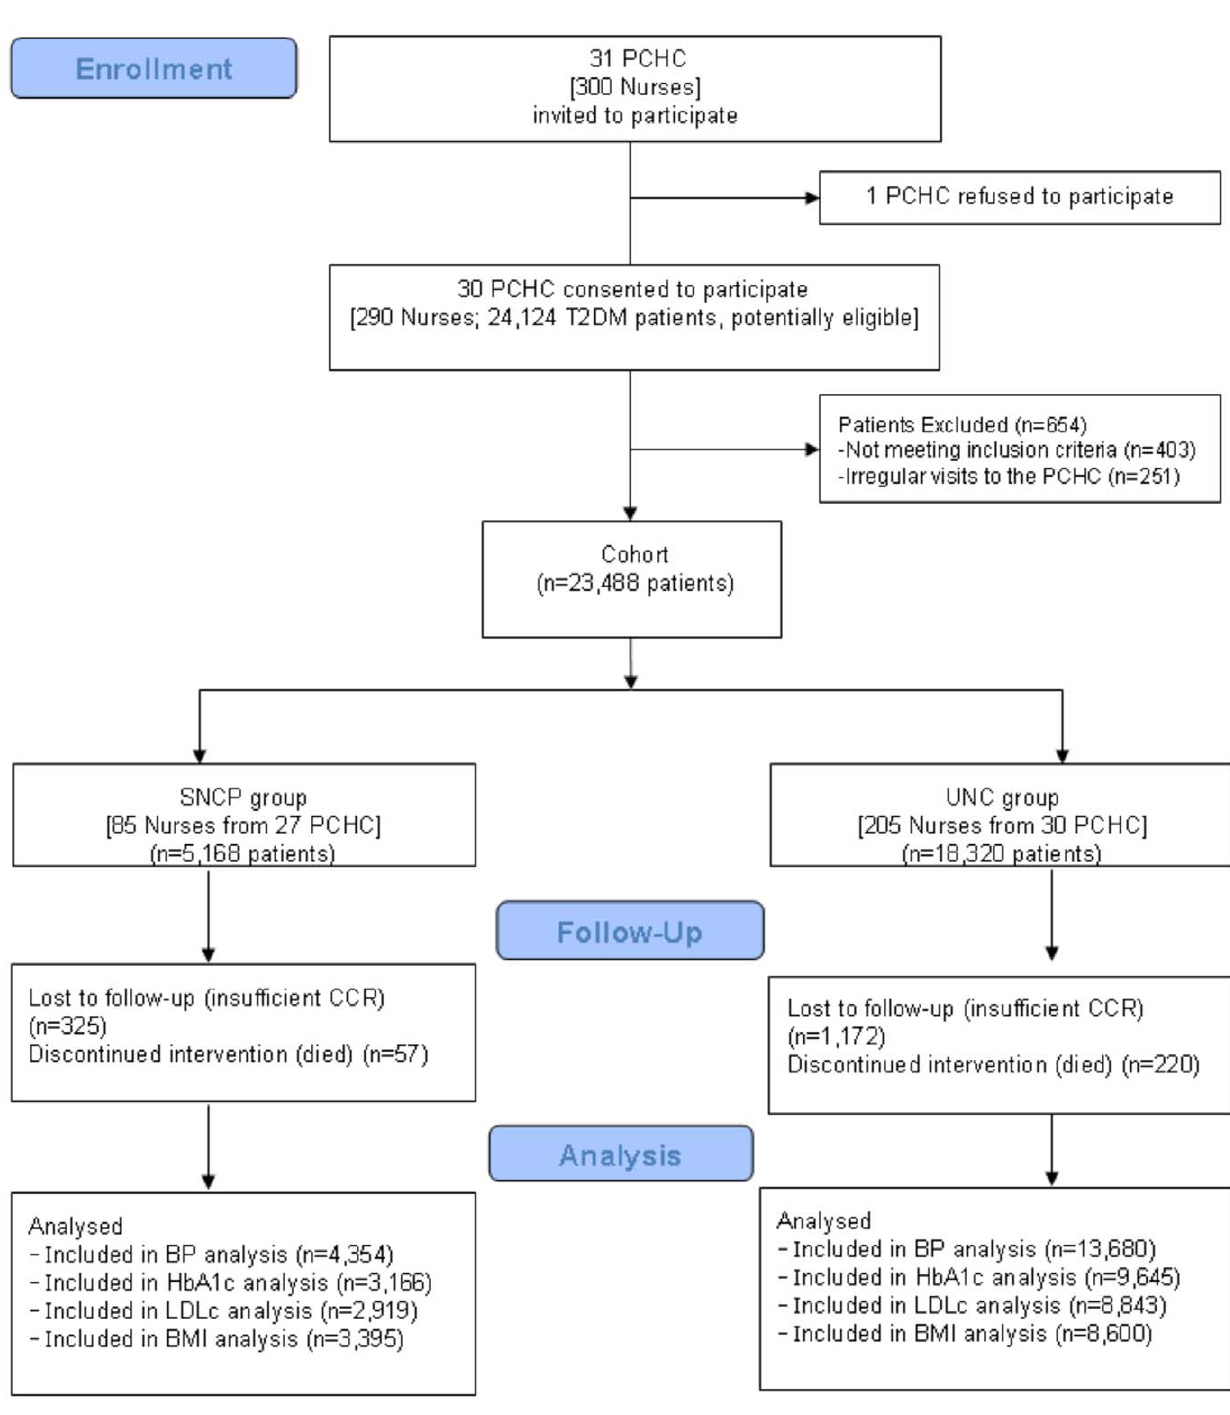
Figure 1. Flow diagram of participants. PCHC: Primary Health Care Center; T2DM: Type 2 Diabetes Mellitus; SNCP: Standardized Nursing Care Plans; UNC: Usual Nursing Care; CCR: Computerized Clinical Records; BP: Blood Pressure; HbA1c: Glycated hemoglobin; LDLc: Low-density lipoprotein cholesterol; BMI: Body Mass Index.